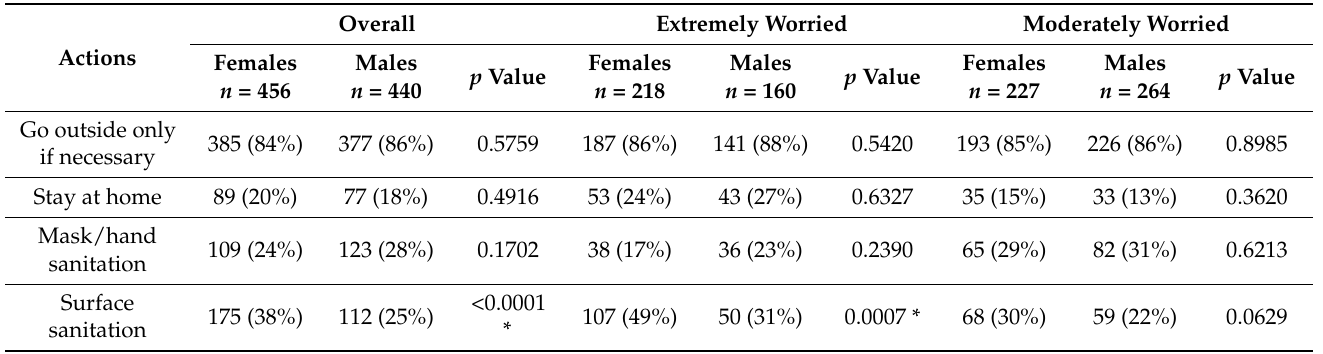
Table 3. Gender differences in actions for containing COVID-19 spreading.